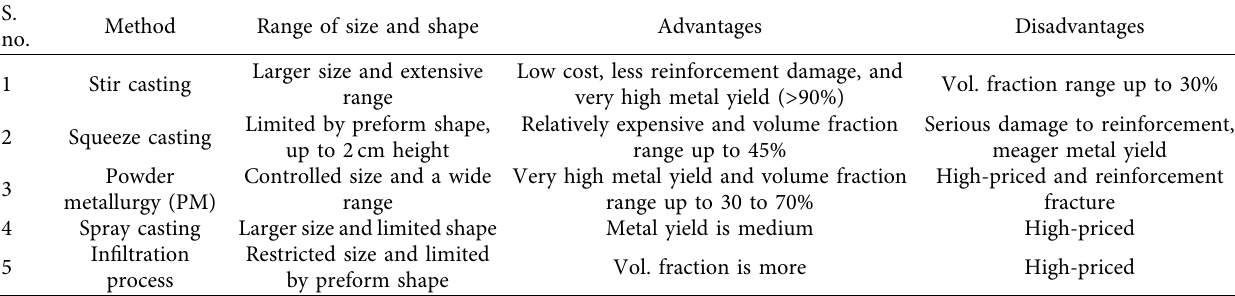
Table 4: Comparative study of various manufacturing techniques of MMCs